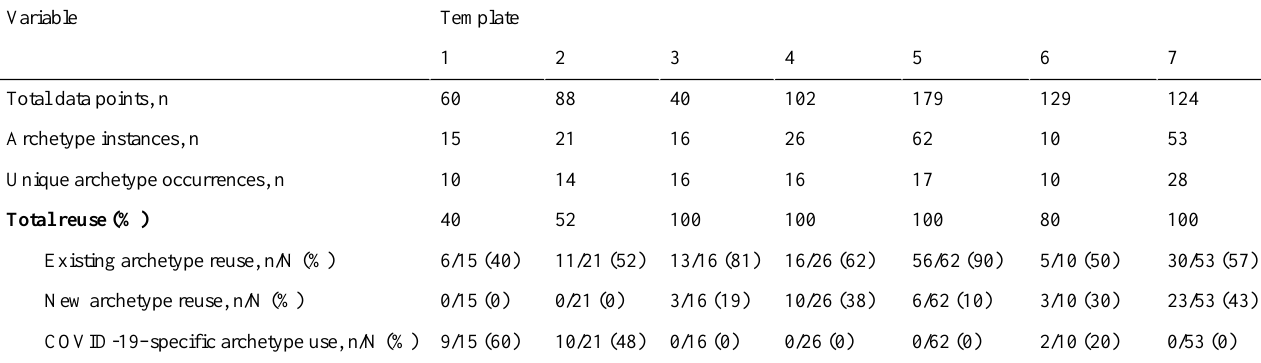
Table 1. Reuse per